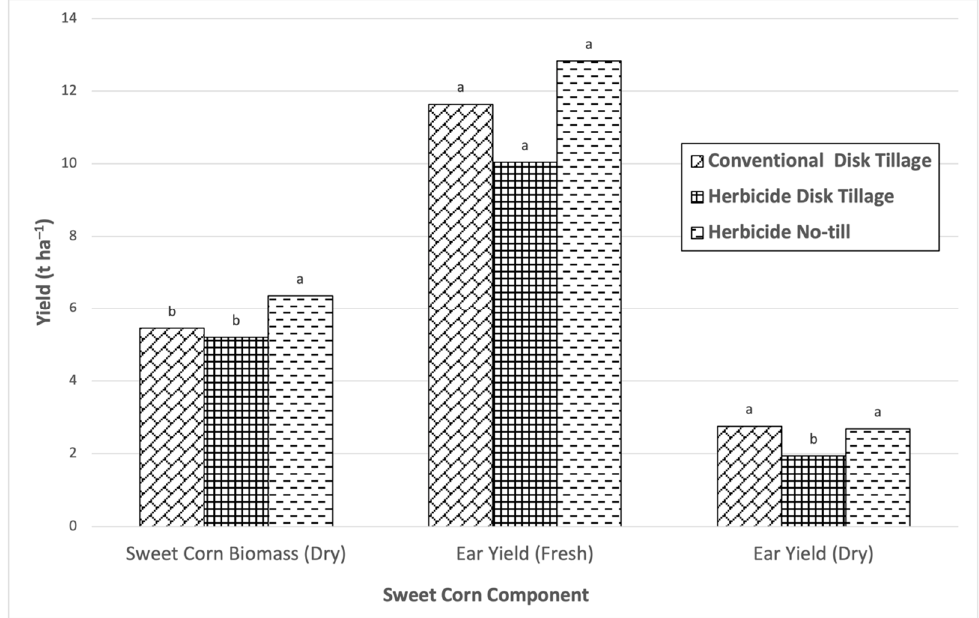
Figure 1. Mean dry sweet corn biomass and ear yield as a function of cover crop termination method in 2020. For each response variable, columns marked with the same letter are not significantly different from each other according to Tukey’s HSD adjusted t tests at p ≤ 0.05.